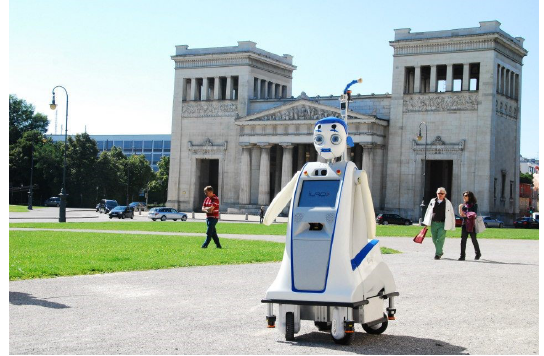
Figure 1: Interactive Urban Robot - IURO: A robot that is lost and has to find its way without any topological